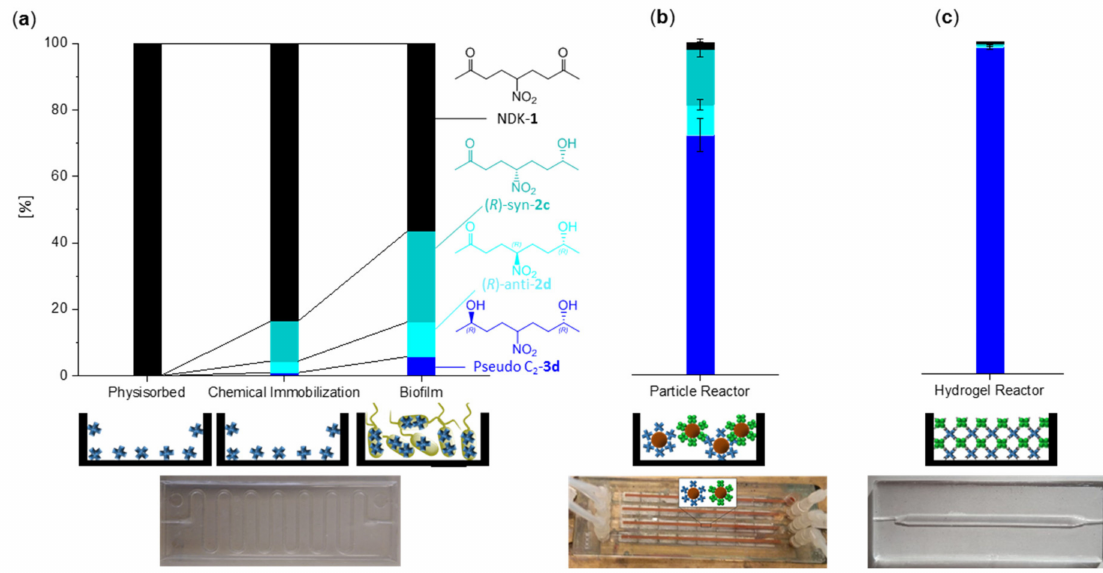
Figure 2. Flow biocatalytic conversion of NDK 1 to ( R )-syn/anti-hydroketone 2c/d and diol 3d . The bar graphs show the product distribution obtained from the various different reactor modules, i.e., the meander channel ( a ) with physisorbed or chemically immobilized pure enzyme or whole-cell biofilm intracellularly expressing the LbADH–SBP, ( b ) the packed-bed reactor with LbADH–SBP and GDH–SBP immobilized on individual magnetic particles and ( c ) the all-enzyme LbADH–SC/GDH–ST hydrogel filled reactor module. All modules were perfused with a substrate solution containing 10 mM NDK 1 . Product distributions were determined by quantitative HPLC analysis. Note that the stereoselectivity of all reactor modules was determined exclusively by the incorporated